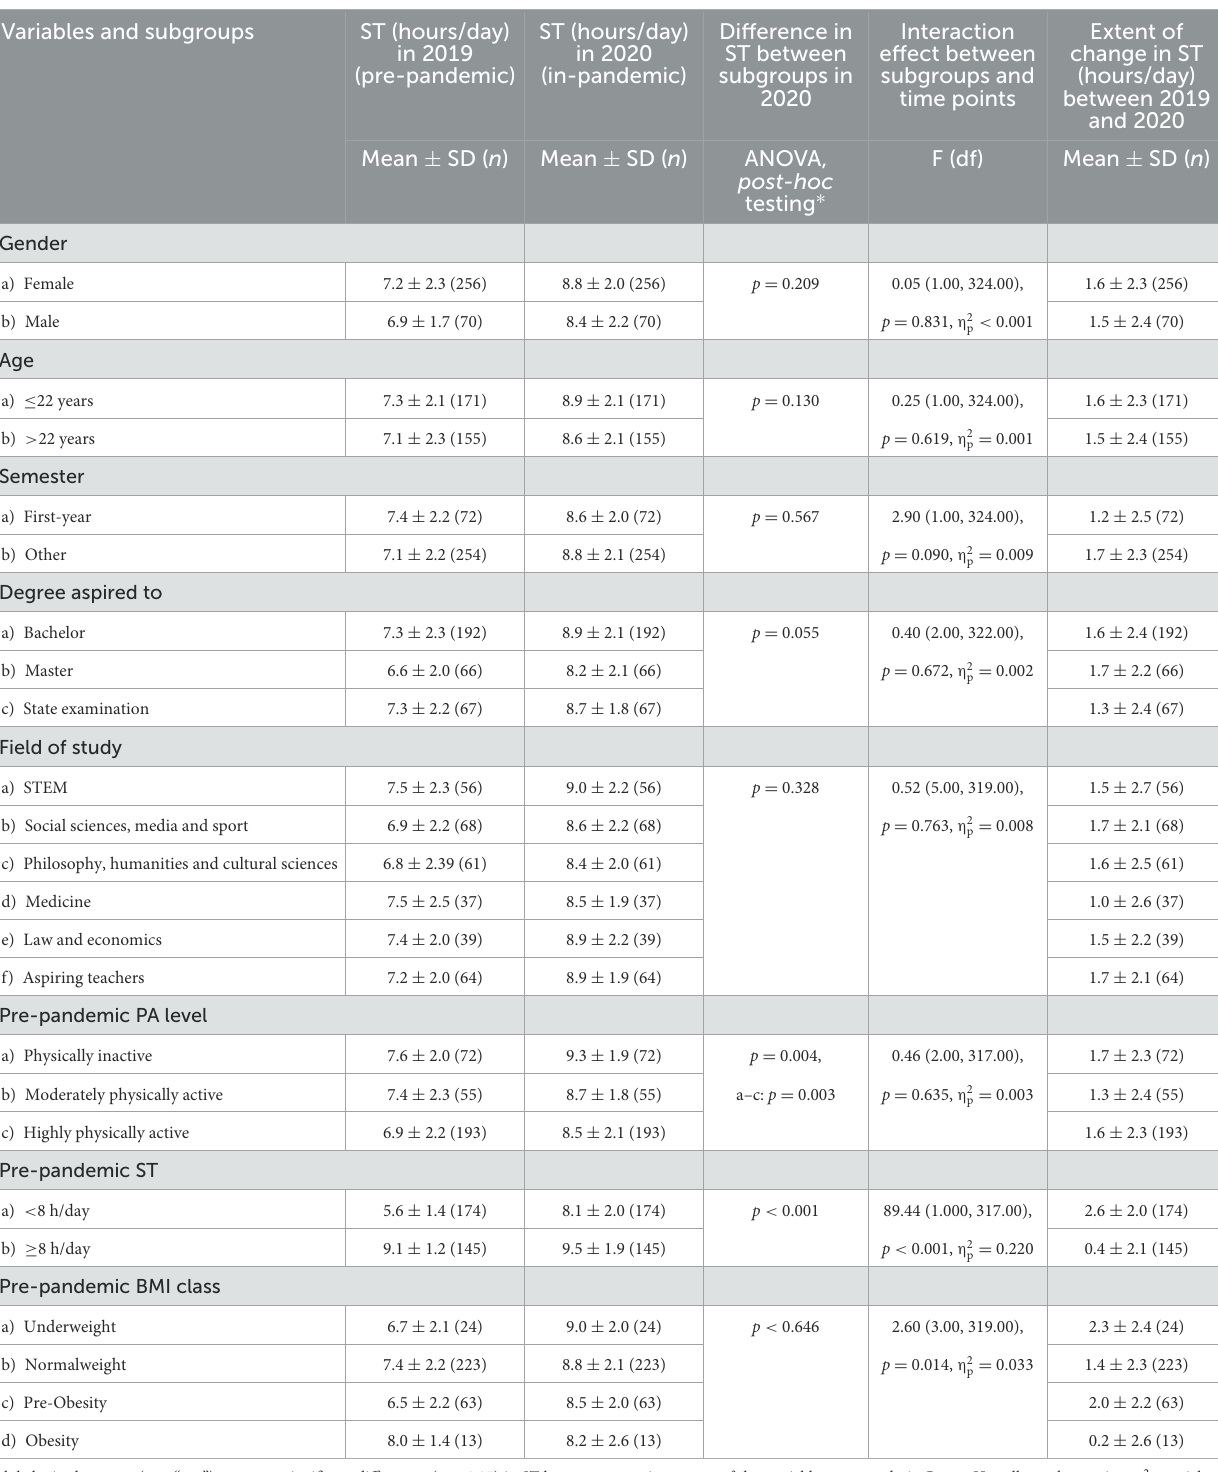
TABLE 2 Means, standard deviations (SD), and analyses of variance in sedentary time (ST) by time point (“2019 pre-pandemic” and “2020 in-pandemic”), sociodemographic, study-related and physical health related variables of the longitudinal study